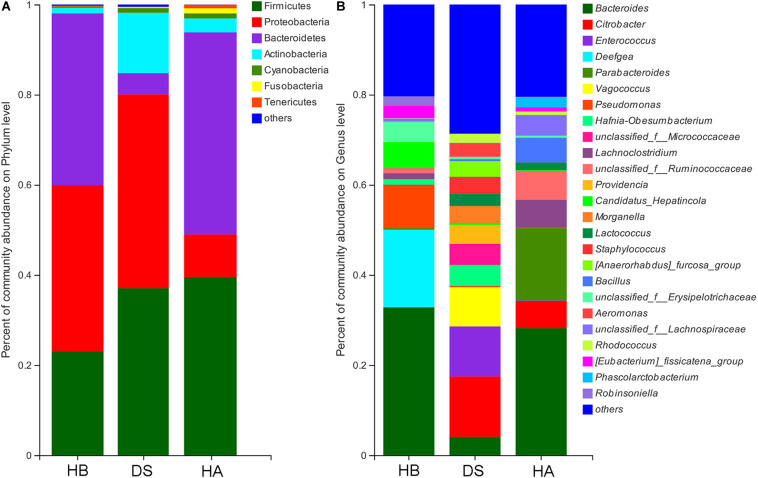
Community bar plot analysis of bacteria at the phylum (A) and genus (B) levels. Only genera with relative abundances over 2% in at least one sample are shown here.